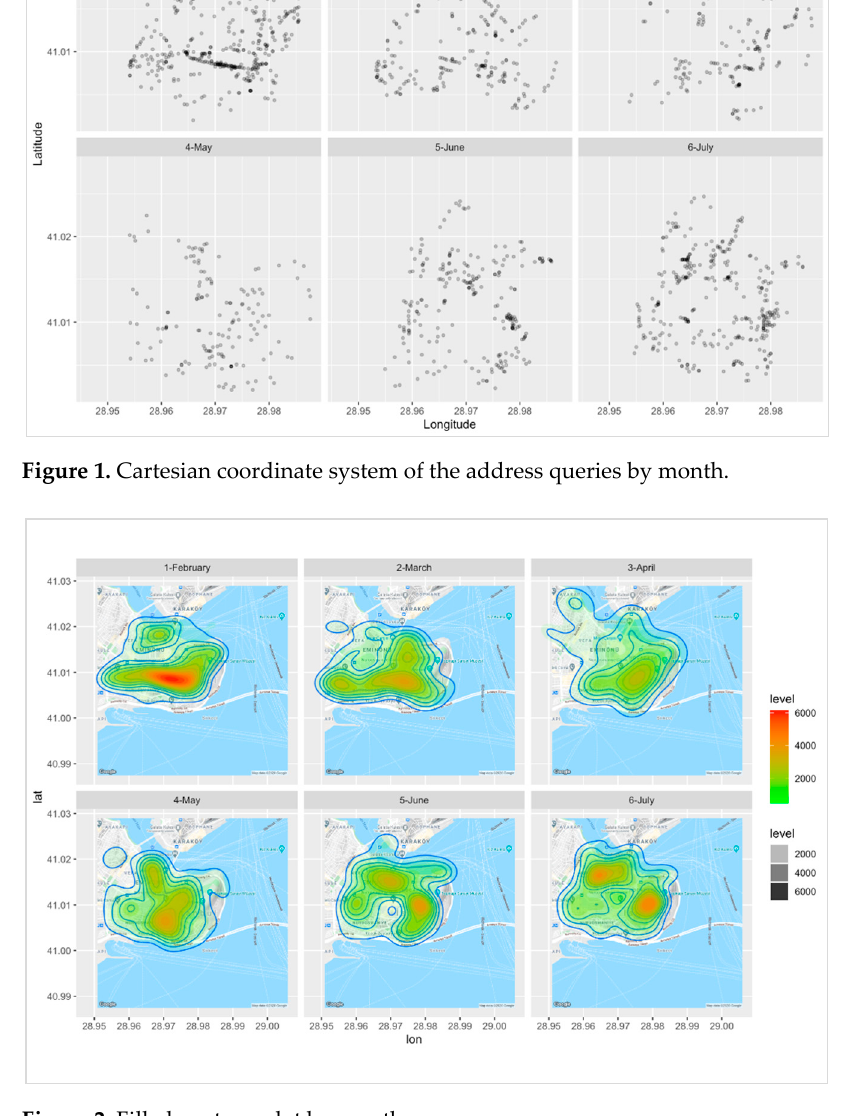
Figure 2. Filled contour plot by